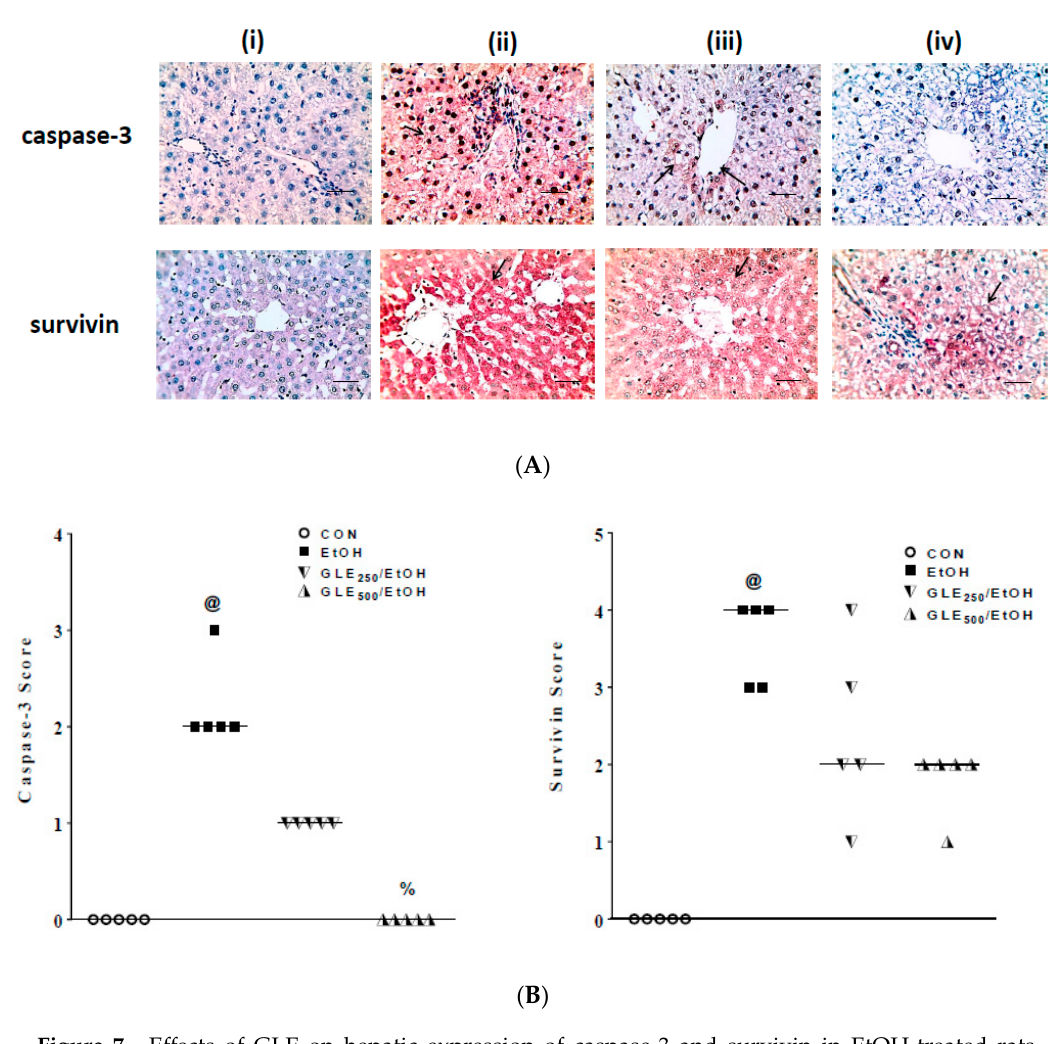
Figure 7. Effects of GLE on hepatic expression of caspase-3 and survivin in EtOH-treated rats. Representative photomicrographs of immunohistochemical detection of caspase-3 and survivin in livers from CON (i), EtOH (ii), GLE 250 / EtOH (iii) and GLE 500 / EtOH (iv) groups ( A ). Scatter-dot plot showing the score of caspase-3 (left panel) and survivin (right panel) in the same groups ( B ). Median is indicated by a line ( B ). @,% p ≤ 0.05 compared with CON and EtOH groups, respectively. Statistical analysis was performed using Kruskal–Wallis followed by Dunn’s multiple-comparison test (n = 5). CON: control, EtOH: ethanol, GLE: grape leaf extract.